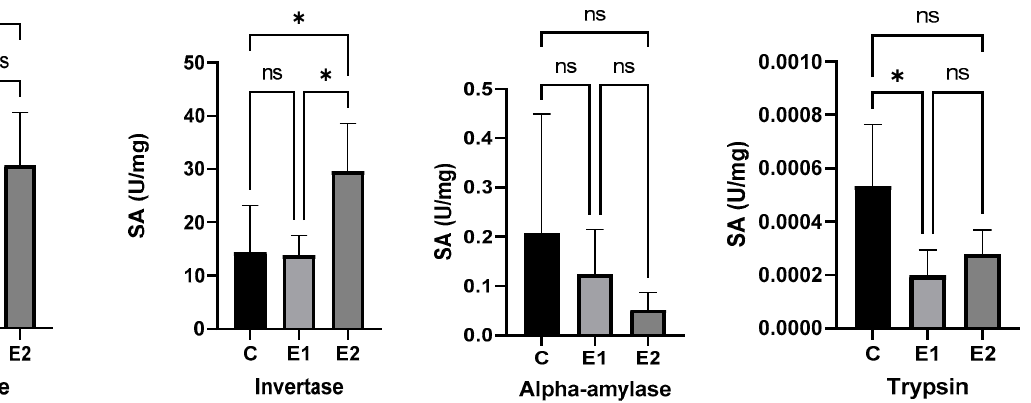
Figure 3. Effect of watermelon rind (E1) and sea buckthorn meal (E2) supplementation on the enzymatic specific activity (SA) of maltase and invertase, expressed as U/mg protein, from the duodenum mucosa. Significant at * p ≤ 0.05; significant at ** p ≤ 0.01; ( n = 6); n: number of replicates; ns: none significant.